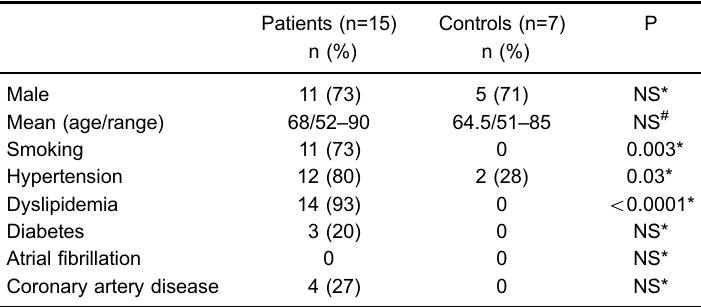
Table 1. Demographic data and vascular risk factors in carotid stenosis patients and age-matched